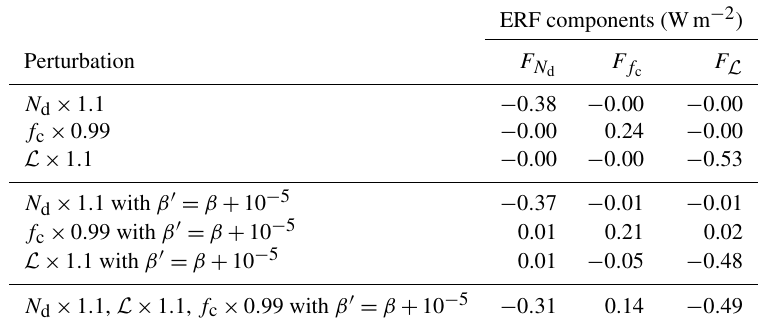
Table A1. ERF aci components resulting from idealized perturbations to N d , L , and f c ; estimate of the same ERF aci components by forward– backward PRP in the presence of decorrelation effects.